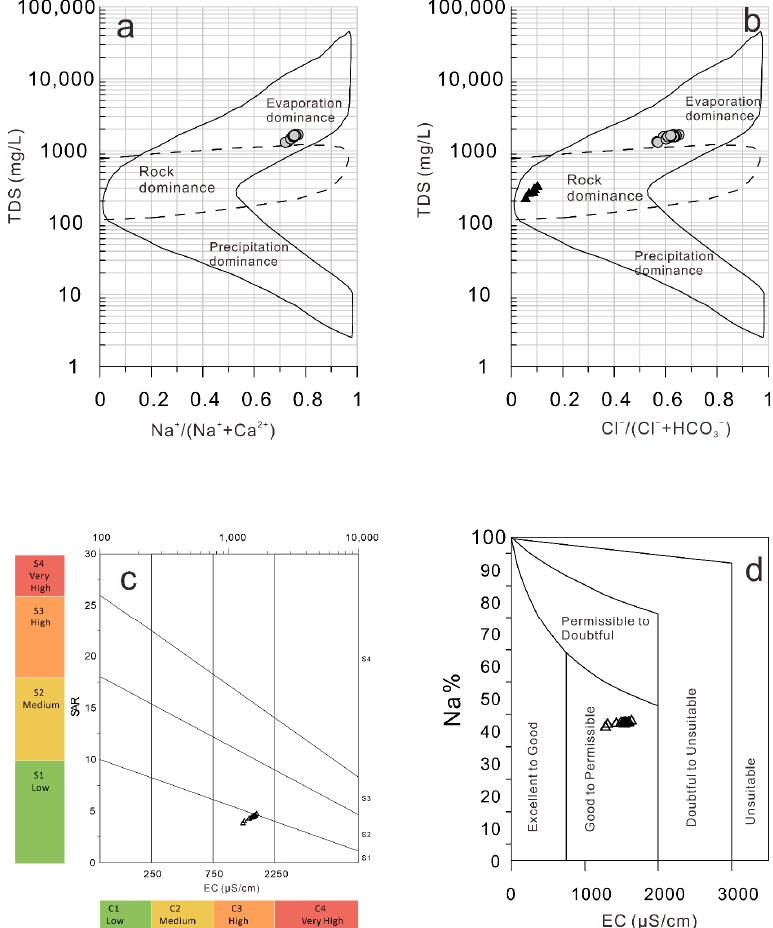
Figure 8. Gibbs diagrams ( a and b ) for river water and lake water in the Bosten Lake basin (circles represent Bosten Lake water, and triangles represent Kaidu River water [65] ) and the assessment of the irrigation suitability of Bosten Lake water; c : classification diagram from the United States Salinity Laboratory with EC vs. the sodium absorption ratio (SAR) and d : Wilcox diagram with EC vs. the sodium percentage (Na%).